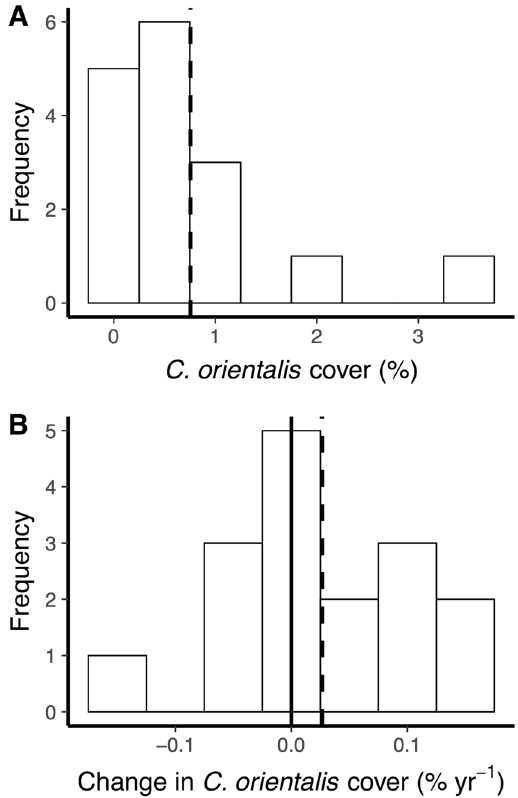
Figure 1. ( A ) Average percent cover of Cliona orientalis at the 16 sites used to measure changes over time. ( B ) Changes in Cliona orientalis cover per year. Changes in percent cover were estimated using linear regression and represent the average of 1–4 trends at each location. Dashed vertical lines indicate means and the solid vertical line indicates a value of zero.